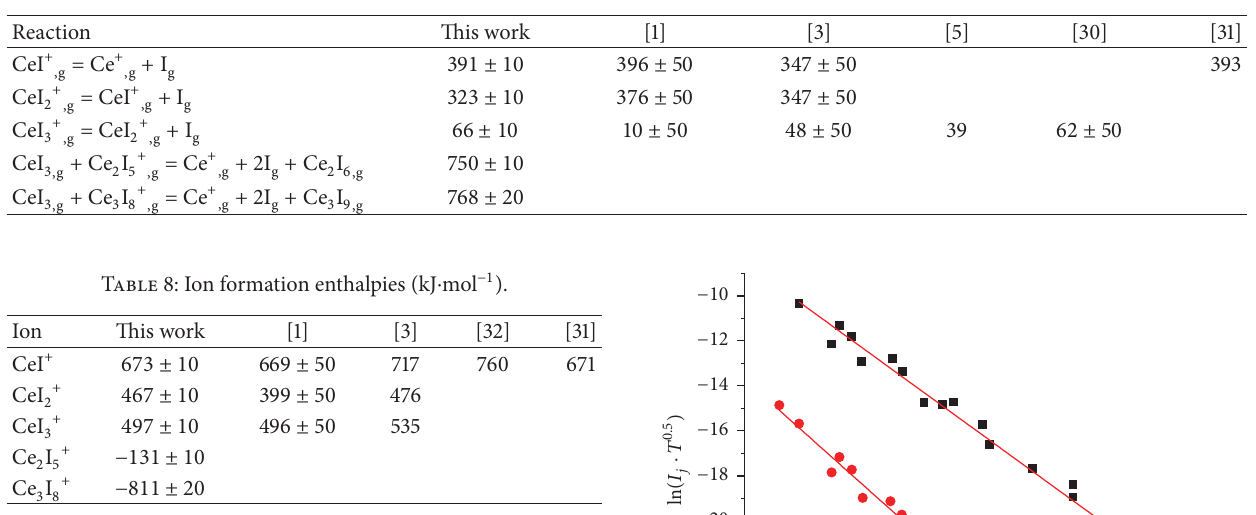
Table 7: Ion-molecular reactions (kJ ⋅ mol −1 ).